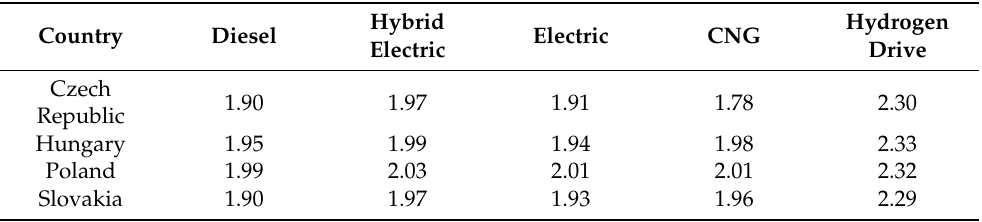
Table 11. Cost of a vehicle-kilometer of mega buses (18 m) with different drive types in V4 countries for the entire period of vehicle operation ( € ). Hybrid Country Diesel